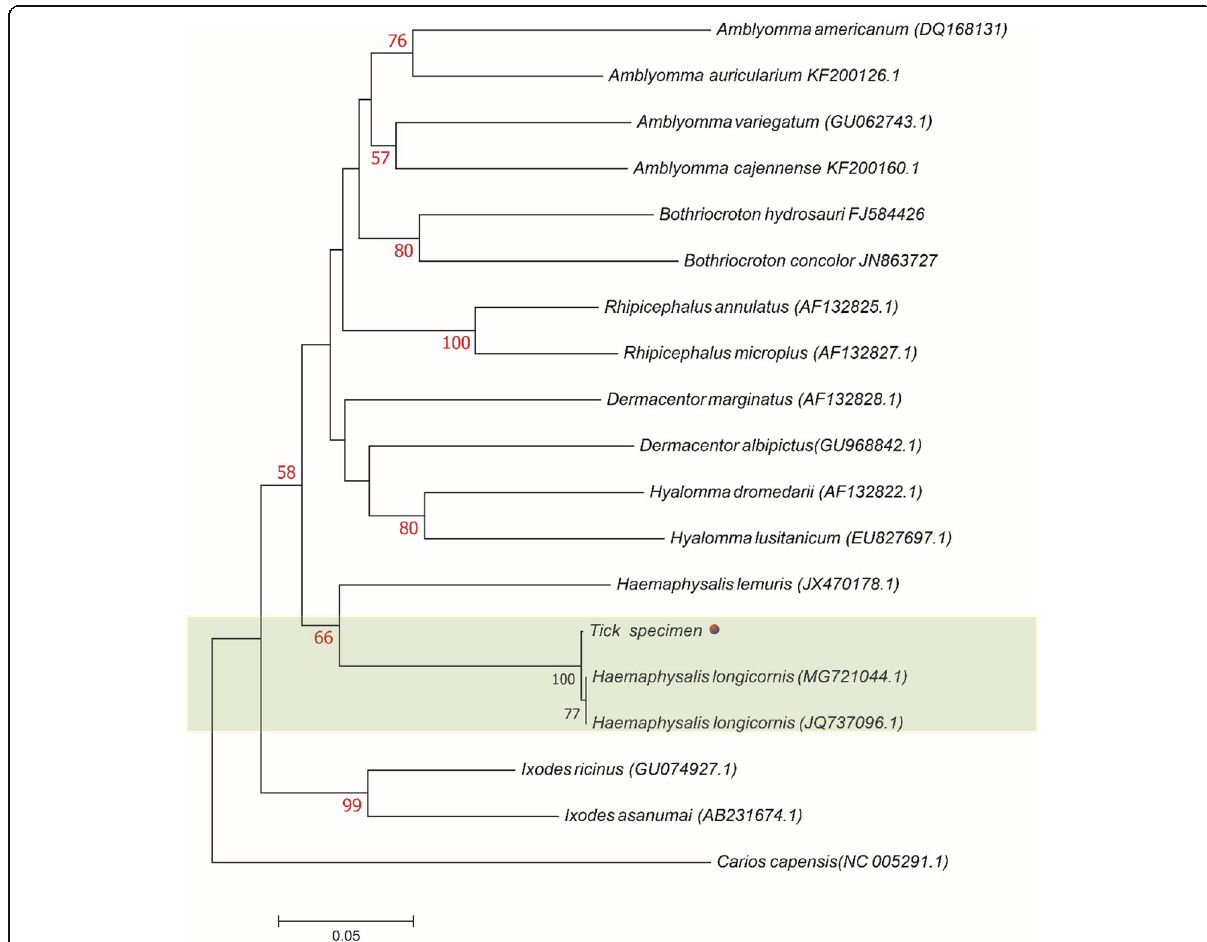
Fig. 1 Phylogenetic analyses of tick species based on COI . Neighbor-joining phylogenetic analysis based on partial tick COI sequences. Bootstrap values are indicated at the nodes. The scale bar indicates the degree of divergence represented by a given length of a branch. The red dot indicates the COI sequence acquired in this